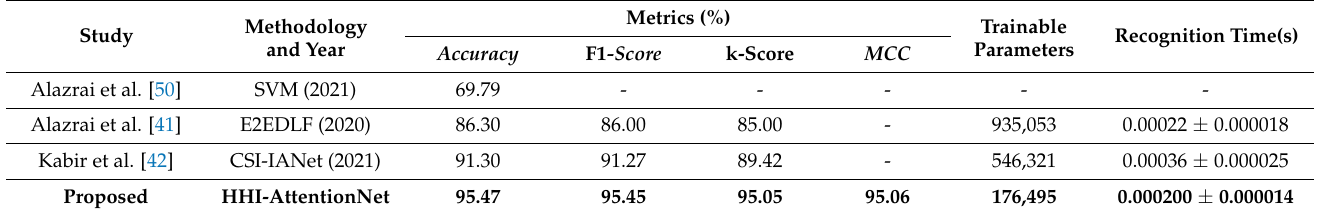
Table 5. Performance comparison of the proposed method with the existing methods on the CSI HHI dataset. Boldface denotes the highest performance, (-) denotes non-available